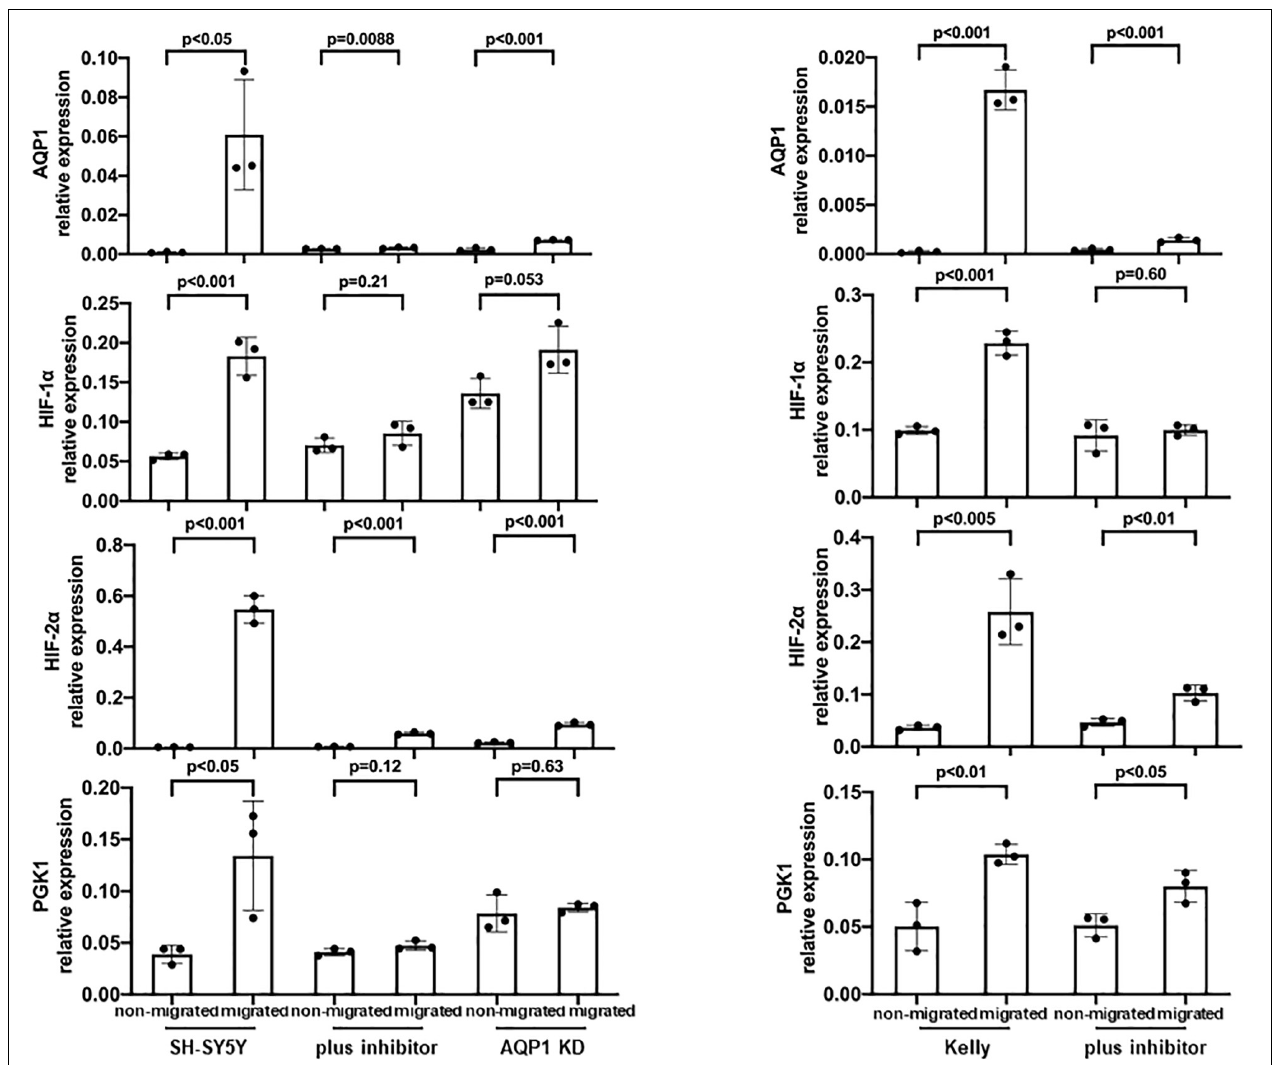
FIGURE 5 | Inhibition of AQP1 and its effect on hypoxia-related factors. AQP1 mRNA expression of migrating SH-SY5Y and Kelly neuroblastoma cells is decreased through AQP1 inhibition by both the AQP1 inhibitor and in case of SH-SY5Y cells through the AQP1 knock-down construct. HIF-1 α expression is not compromised in the knock-down and only partially under AQP1 inhibition. HIF-2 α expression is down-regulated in the SH-SY5Y AQP1 knock-down and through AQP1 inhibition, while changes of PGK1 expression in either are not relevant. The experiment was performed twice, RNA triplicates were used for qPCR analysis each time and student’s t -test for analysis of